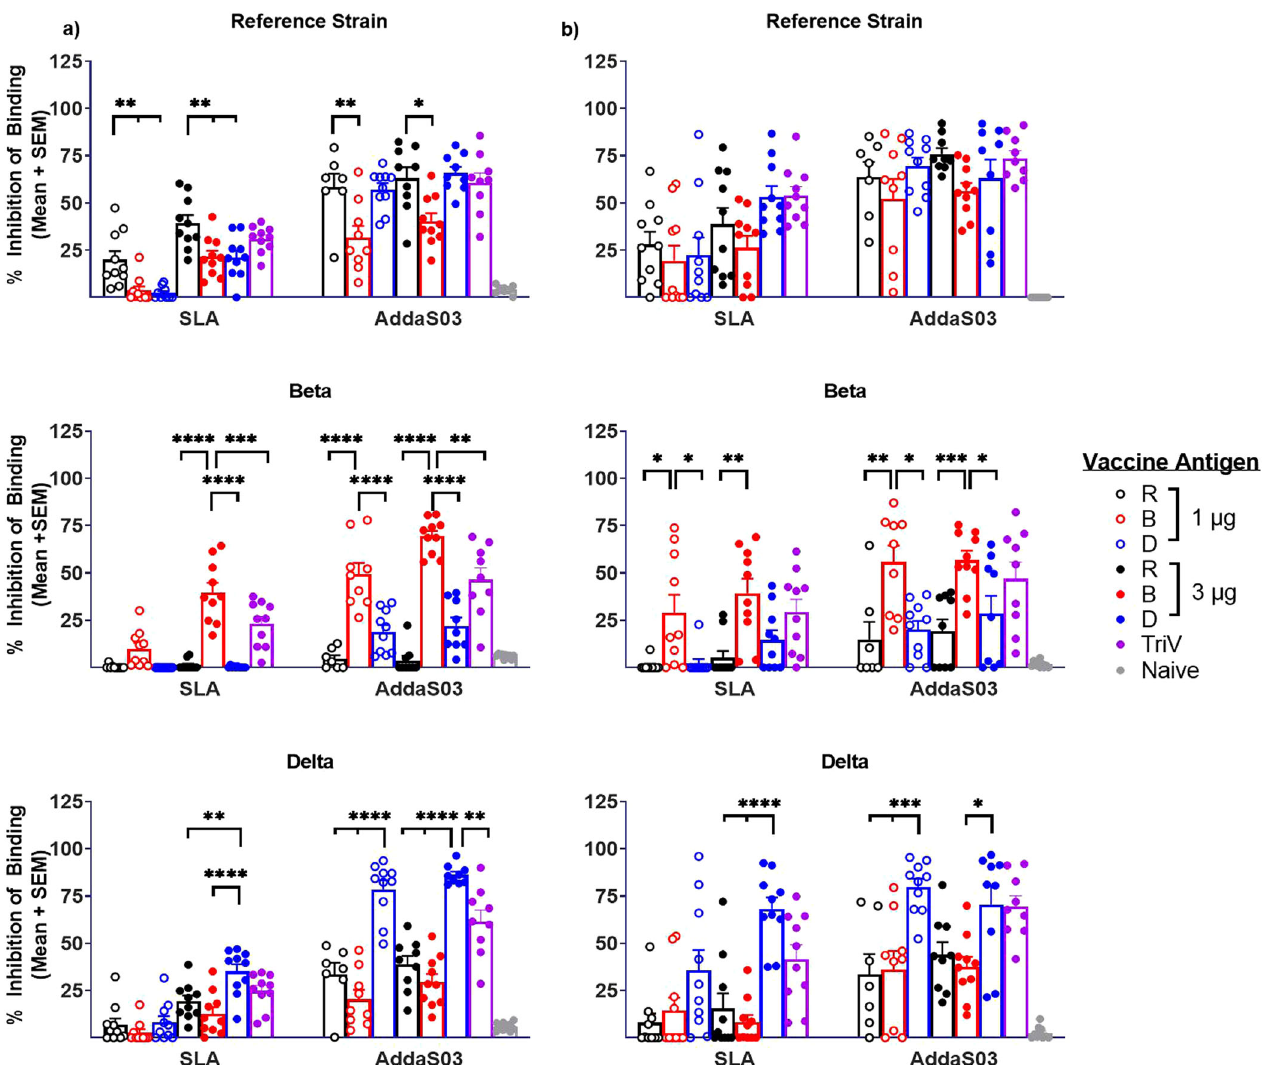
Fig. 2 Neutralization activity induced by VOC-based subunit vaccine formulations. C57BL/6 mice ( n = 10/group) were immunized i.m. with SmT1v3 reference strain ‘ R ’ , Beta ‘ B ’ and/or Delta ‘ D ’ adjuvanted with SLA or AddaS03 on days 0 and 21. Serum from day 20 ( a ) at a fi nal serum dilution of 1:25 and day 28 ( b ) at a fi nal serum dilution of 1:250 were analyzed by SARS-CoV-2 Spike-ACE2 binding assay against the spike from the reference strain, Beta VOC or Delta VOC. Grouped data is presented as mean + standard error of mean (SEM). For statistical analysis, the signi fi cant differences are indicated between all groups receiving an equivalent dose of total antigen when compared against the group that received the antigen corresponding to the test strain: * p < 0.05, ** p < 0.01, *** p < 0.001 and **** p < 0.0001 by one-way ANOVA followed by Tukey ’ s multiple comparisons